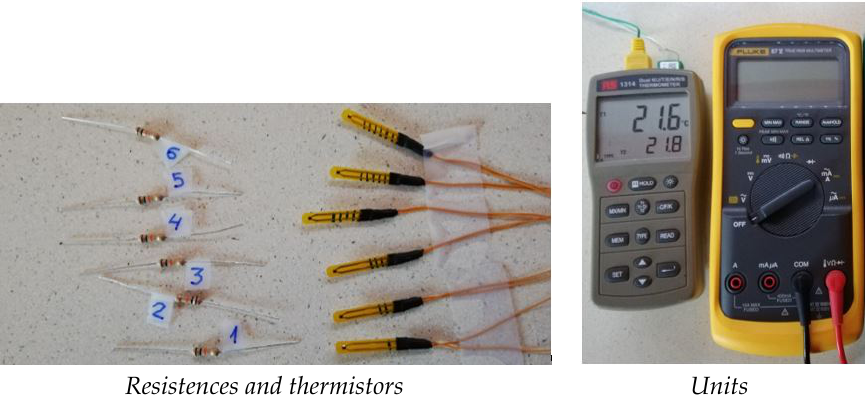
Figure 9. Units calibrated to take the temperature and measure the resistance.